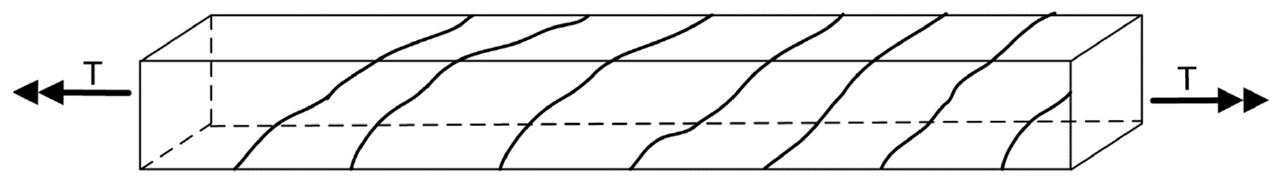
Table 4. Summary of relevant data corresponding to cracks in reinforced concrete structures result- ing from various interactions; N , M , V , T —description in the text.